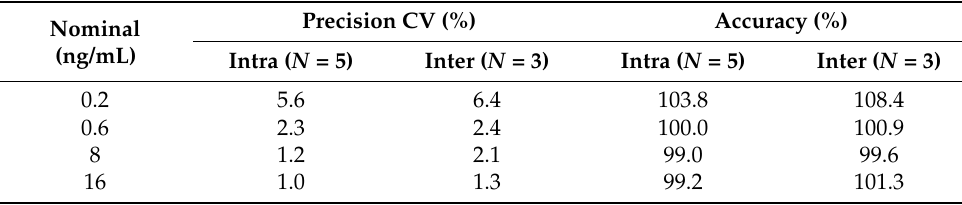
Table 1. Accuracy and precision for the analysis of p -Coumaric acid in human plasma.